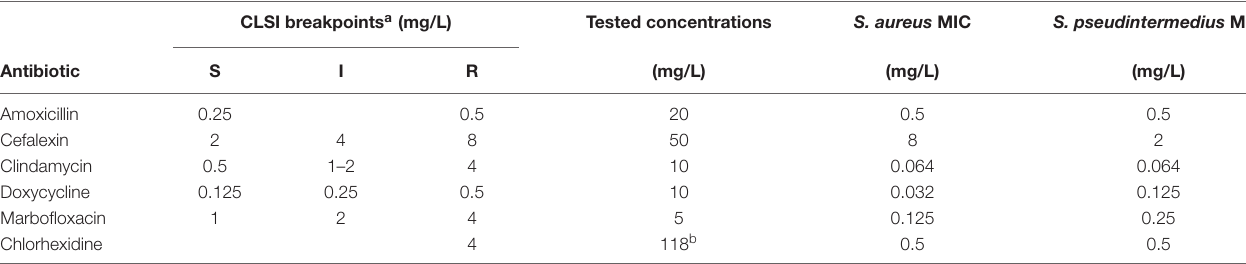
TABLE 1 | CLSI and chlorhexidine breakpoints (Horner et al., 2012; CLSI, 2016), tested antibiotic or biocide concentrations on in vitro biofilms and MIC of the antibiotic drugs for the selected strains of Staphylococcus aureus and Staphylococcus pseudintermedius. CLSI breakpoints a (mg/L)